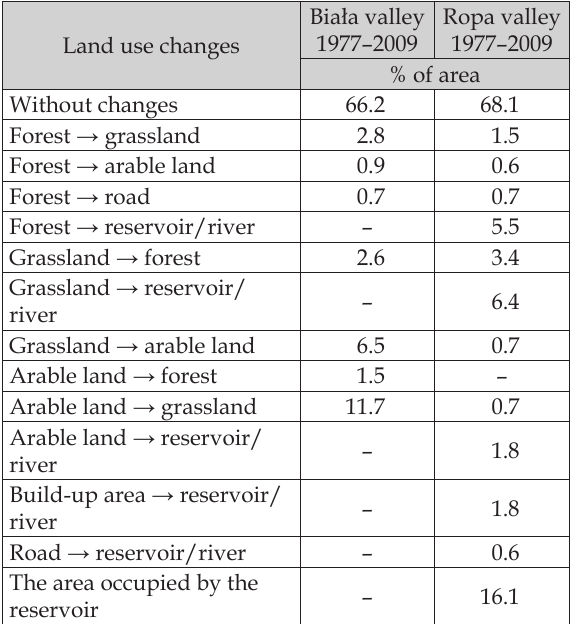
Table 3. Directions of land use changes (taking into account only > 0.5% changes of the total surface of the tested area.